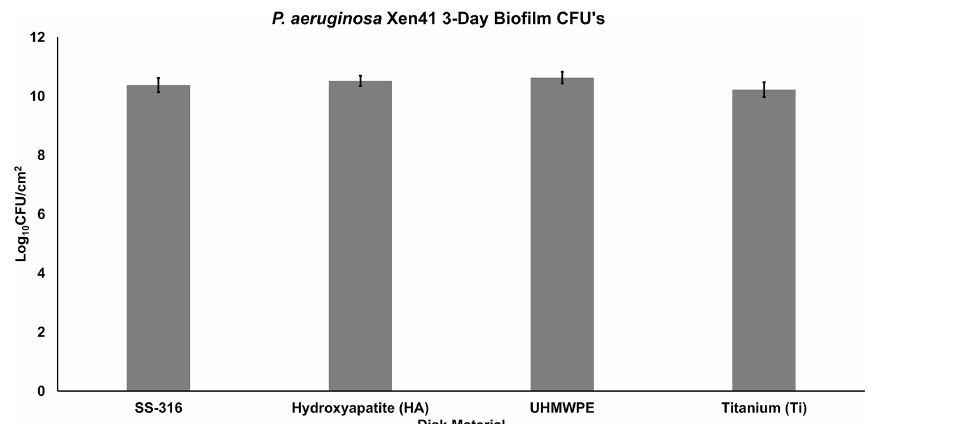
Figure 3. Quantification of viable bacteria (by CFU) on discs containing P. aeruginosa Xen41 3d biofilm. Counts are reported in terms of log 10 CFUs per surface area of the disc (in cm 2